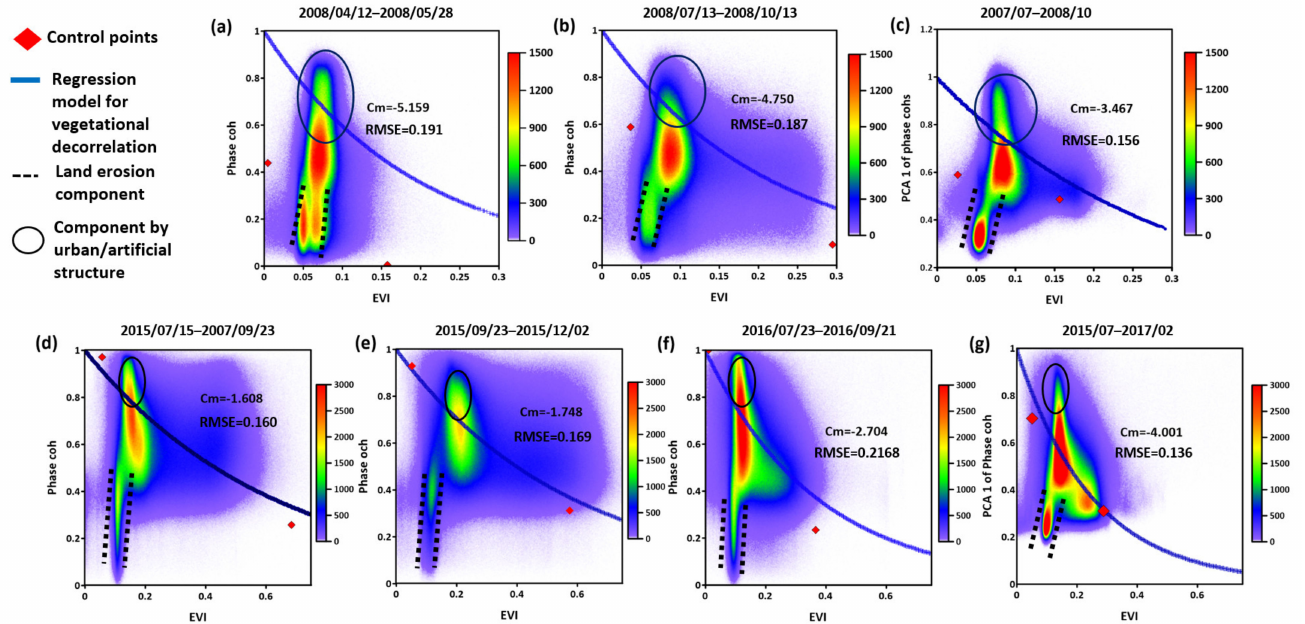
Figure 5. ( a , b ) The scattergram between the Enhanced Vegetation Index (EVI) and its corresponding single-phase coherence from the PALSAR-1 InSAR pair by a prior processor, ( c ) The scattergram between the EVI and PCA 1st component from the PALSAR-1 phase coherence time-series by a posterior processor, ( d – f ) The scattergram between the EVI and its corresponding single-phase coherence from the PALSAR-2 InSAR pair by a prior processor, ( g ) The scattergram between the EVI and PCA 1st component from the PALSAR-2 phase coherence time-series by a posterior processor. The corresponding regression models were presented as blues lines. Control points indicating high EVI, low phase coherence, and low EVI and high phase coherence were indicated by red points. The color represents the cumulative pixel number of the corresponding EVI-PCA bin. RMSEs were measured over the upper area of the land erosion component and demonstrated with the regression model constant Cm of Equation